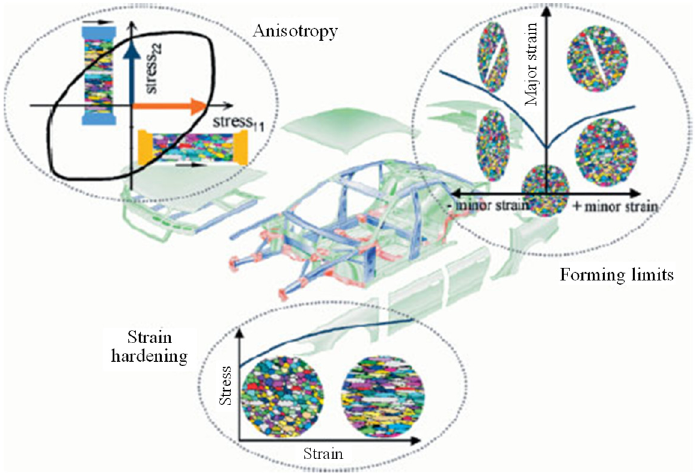
Figure 6. A schematic diagram describing the materials input date used for modern FE technologies to optimize SMF processes. Reprinted from Ref. [73] with permission. Copyright 2002, John Wiley and Sons.